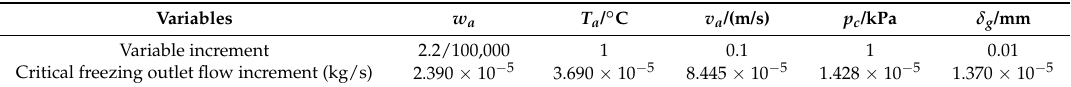
Table 1. Variation of critical freezing outlet